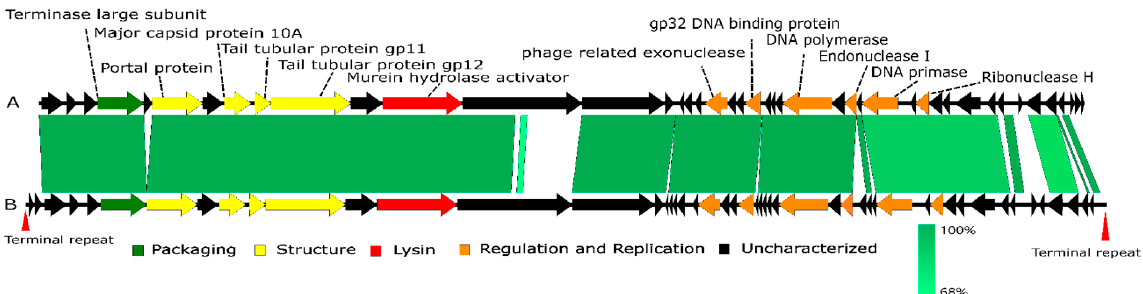
Figure 5 . Genome comparison of the Lbo240-yong1 ( A ) and Phormidium cyanophage Pf-WMP4 ( B ). The color of each arrow refers to the functional groups. The orientation of the arrows indicates the direction of gene transcription. The homologous regions are represented by gray bars, with their depth reflecting the degree of sequence similarity.